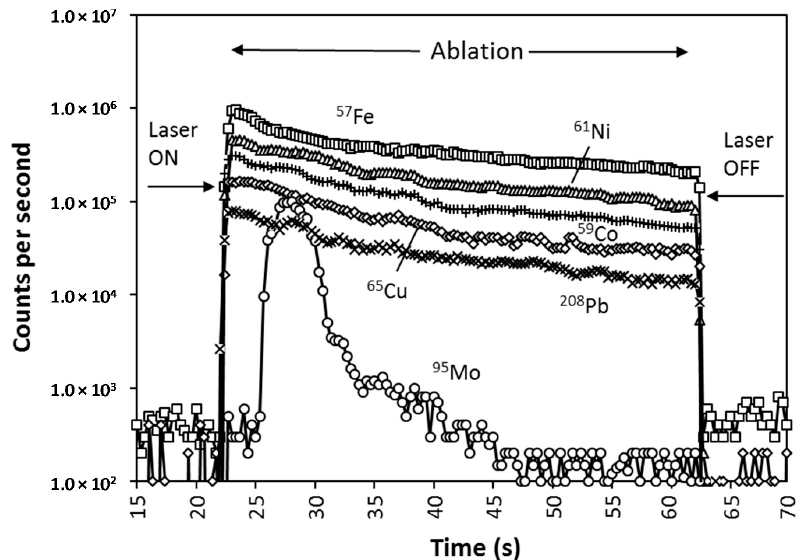
Figure 9. Representative time-resolved LA-ICP-MS depth profile for a sample U-1/4-3 (interstitial low-Fe Pn-Ccp from Cpx-poor Spl lherzolite) showing uneven Mo (isotope 95 Mo) distribution within the analyzed sulfide volume. From the left, the background count is 22 s (not shown completely) followed by 40 s of ablation time, which is integrated, and by 40 s of wash-out time (not shown completely). The laser beam encountered a Mo-rich inclusion at 26 s and had burnt through it at 34 s. A few selected isotopes with uniform distribution are shown for comparison.